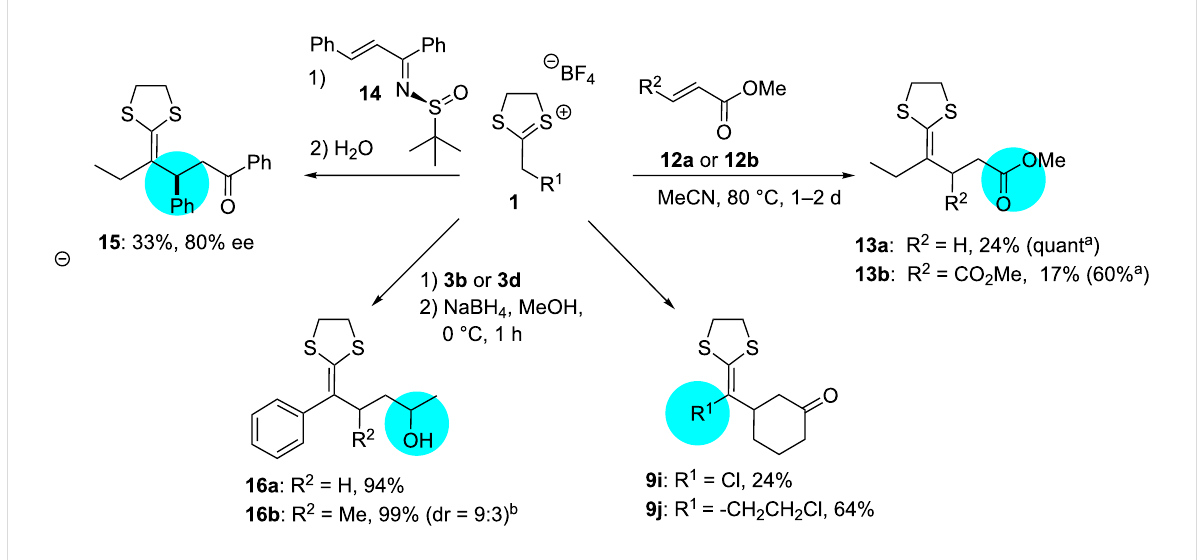
Scheme 5: The scope of the presented protocol demonstrated by examples including the use of additional electrophiles ( 13a , 13b ) or nucleophiles ( 9i , 9j ), the use of a chiral auxiliary ( 15 ) or reductions of the obtained products 4 ( 16a , 16b ). a CH 2 Cl 2 , 1 equiv Me 2 AlCl, rt; 13a : 1 h, 13b : 18 h. b dr was calculated from the 1 H NMR